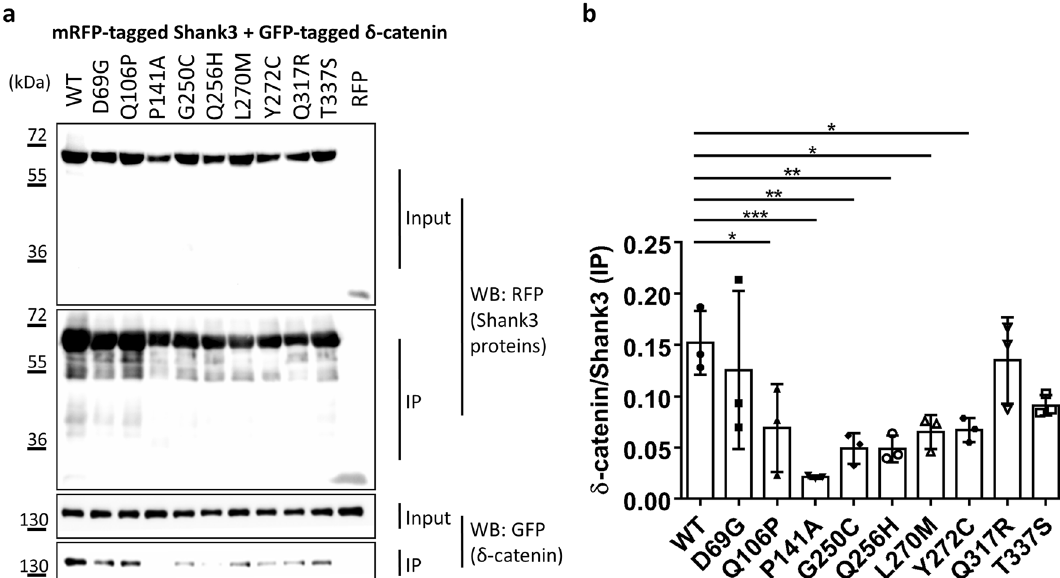
Figure 3. ( a ) RFP-tagged WT and mutant variants of the Shank3 N-terminus (SPN + Ank domains), or mRFP alone, were coexpressed in 293 T cells with GFP-tagged δ-catenin. After cell lysis, RFP-tagged proteins were immunoprecipitated using the mRFP-trap matrix. Input and precipitate samples were analysed by Western blotting using mRFP- (upper panels) and GFP-specific antibodies (lower panels). ( b ) Quantitative analysis. Signal intensities in IP samples for δ-catenin were divided by IP signals for mRFP-Shank3 variants. * , ** , ***Significantly different from WT, p < 0.05, 0.01, p < 0.001, respectively; data from three independent experiments; ANOVA, followed by Dunnett’s multiple comparisons test.